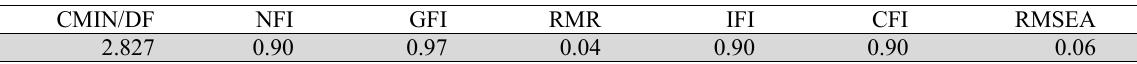
The results of the statistical tests